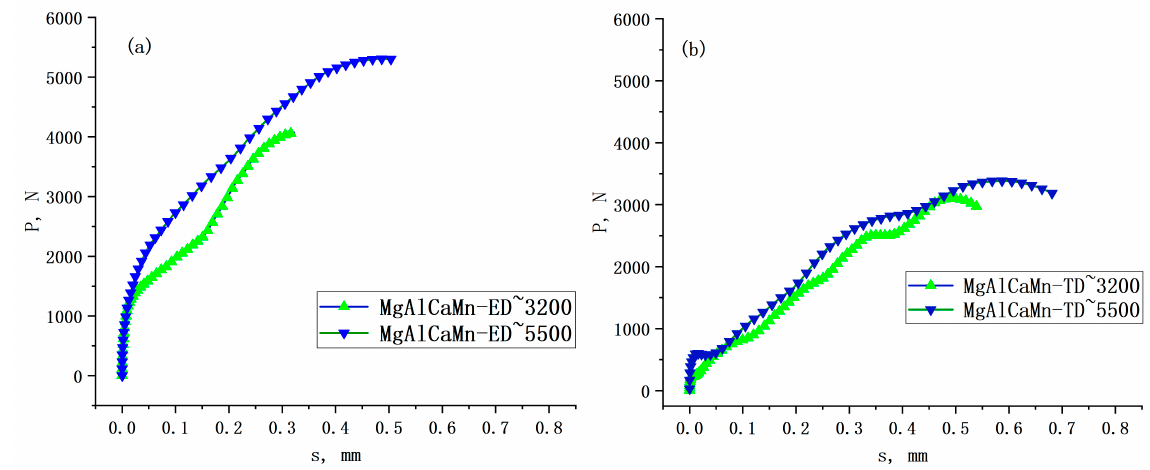
Figure 7. P-s curves of Mg-Al-Ca-Mn alloy under high strain rate compression in the ( a ) ED direction, ( b ) TD direction, and ( c ) Horizontal 45°. Table 3. Energy absorption of Mg-Al-Ca-Mn alloy under high strain rate compression in the ED direction. Strain Rate/s − 1 E/J P max /N P m /N P avr /N CFE SEA/(J/g) 3200 Mg-Al-Ca-Mn Table 4. Energy absorption of Mg-Al-Ca-Mn alloy under high strain rate compression in the TD direction. Strain Rate/s − 1 E/J P max /N P m /N P avr /N CFE SEA/(J/g) 3200 Mg-Al-Ca-Mn Table 5. Energy absorption of Mg-Al-Ca-Mn alloy under high strain rate compression in the Horizontal 45°. Strain Rate/s − 1 E/J P max /N P m /N P avr /N CFE SEA/(J/g) Mg-Al-Ca-Mn